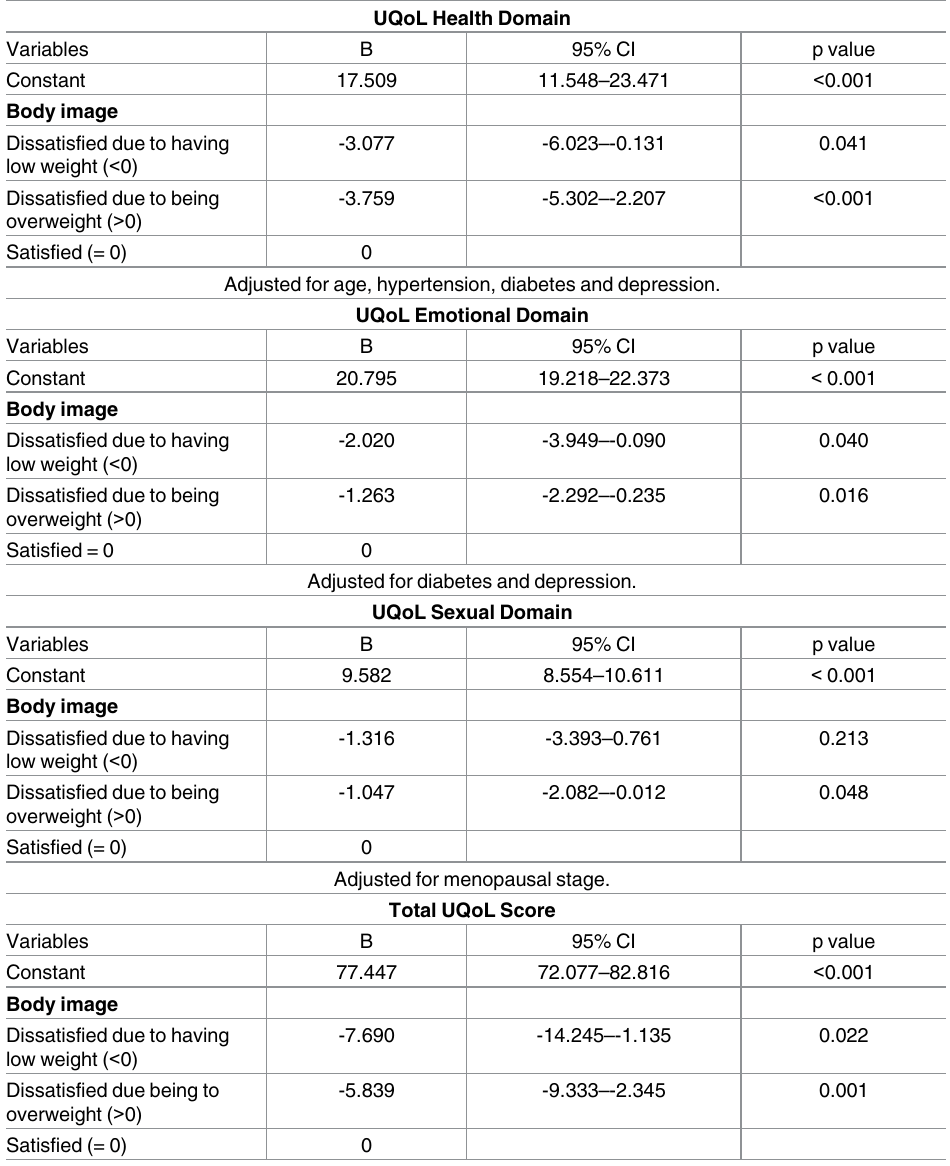
Table 3. Multiple linear regression analysis for the UQoL domains and total score. Parnamirim, RN, Brazil,